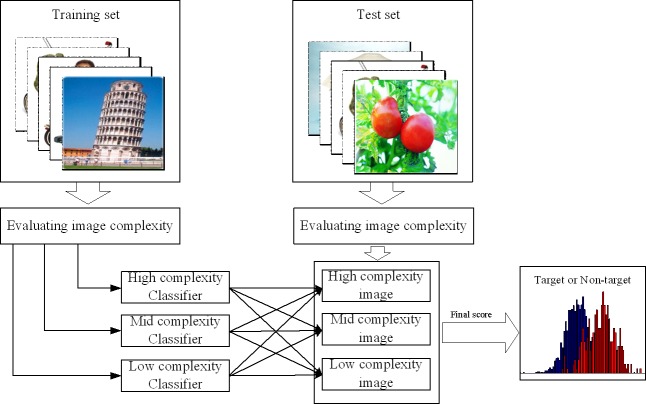
System overview.First, the sample data are divided into equal three parts according to the image complexity (IC). The EEG data induced by high-, medium-, and low-complexity images. We trained the classifiers separately on the different data sets. During testing, we first determined the complexity and category (high-, medium-, or low-complexity image) of the test picture. Then, we calculated the interest scores of the EEG induced by a test image using the corresponding classifier. The result was combined with a certain weight to obtain the final decision score (The image is similar but not identical to the original image, and is therefore for illustrative purposes only).